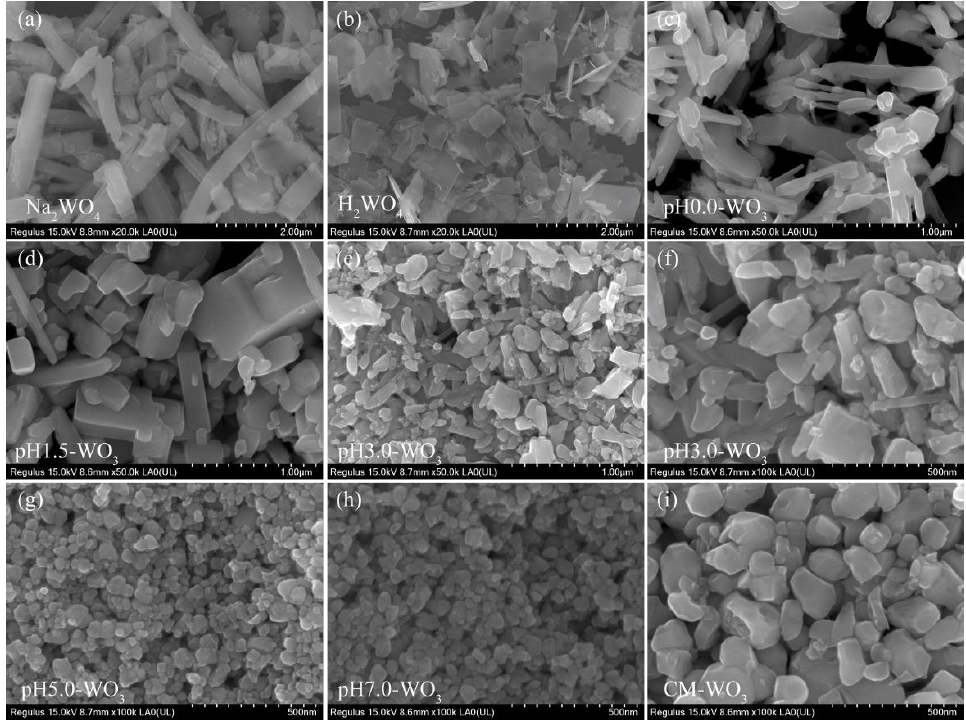
Figure 3. FESEM images for: ( a ) Na 2 WO 4 , ( b ) H 2 WO 4 , ( c ) pH0.0-WO 3 , ( d ) pH1.5-WO 3 , ( e , f ) pH3.0-WO 3 , ( g ) pH5.0-WO 3 , ( h ) pH7.0-WO 3 , and ( i ) CM-WO 3 . WO 3 , ( g ) pH5.0-WO 3 , ( h ) pH7.0-WO 3 , and ( i ) CM-WO 3